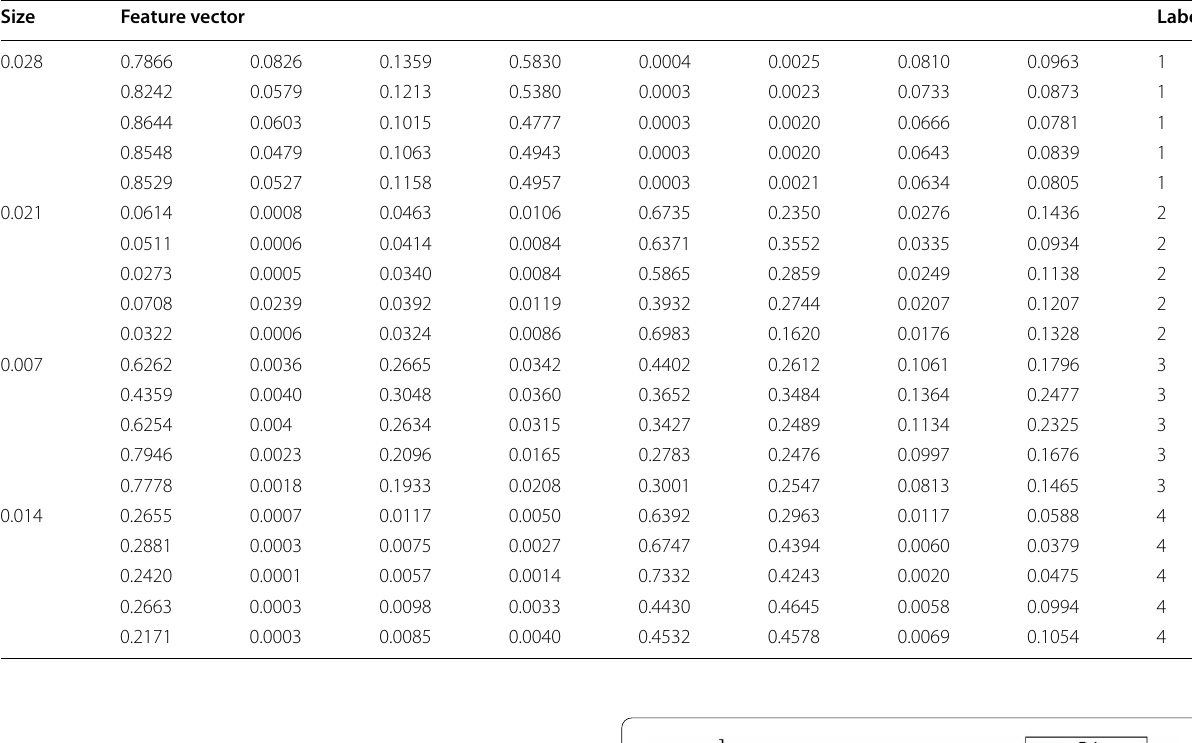
Table 3 Date of the inner ring with different fault diameter